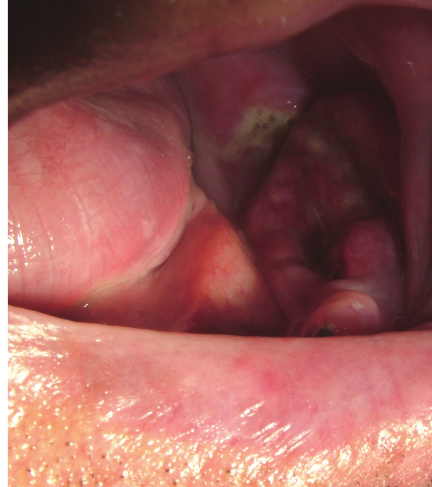
Figure 2: The exophytic mass which developed adjacent to BRONJ, in the left mandible.